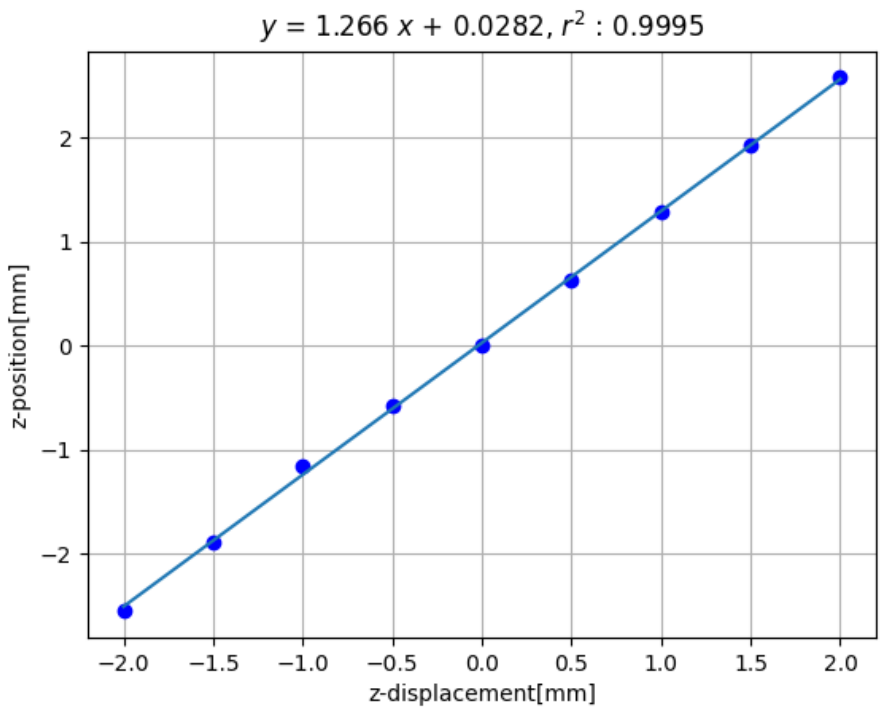
Figure 8. Result of estimation for z -axis displacement by method 2. For Method 1, the horizontal axis represents the displacement in the z -axis from the reference position, whereas the vertical axis directly represents the distance from the camera to the grid pattern. Although it is difficult to determine the true value, the estimated distances show reasonable